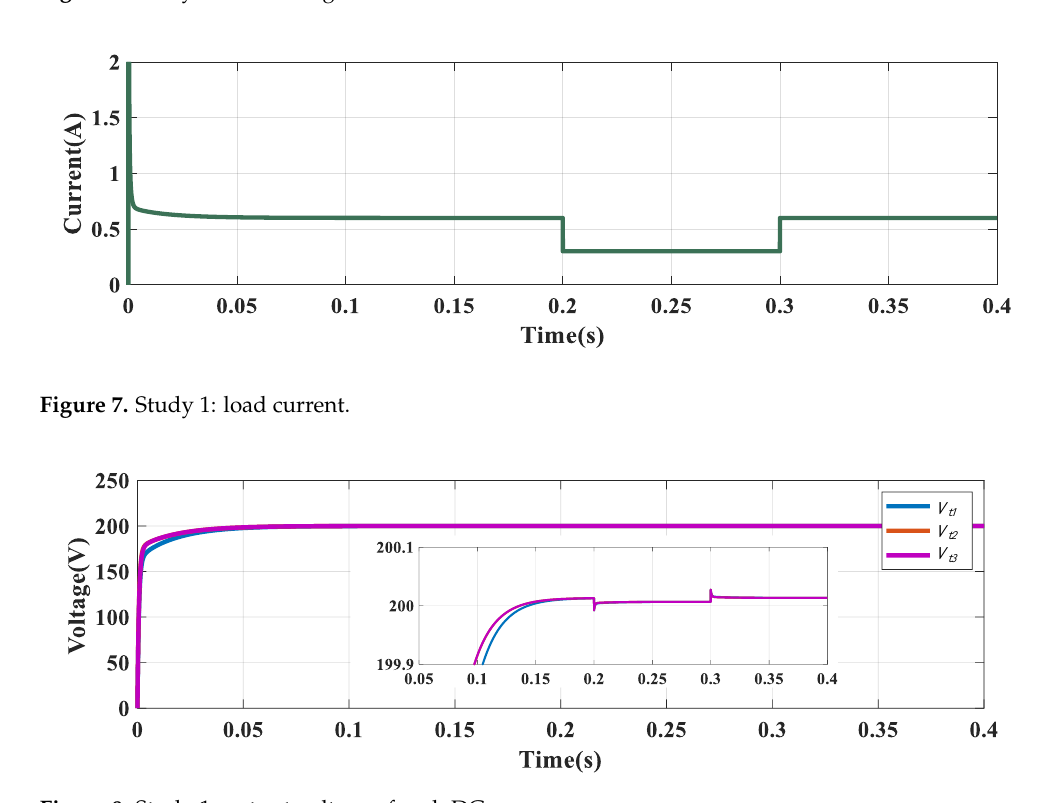
Figure 6. Study 1: load voltage.